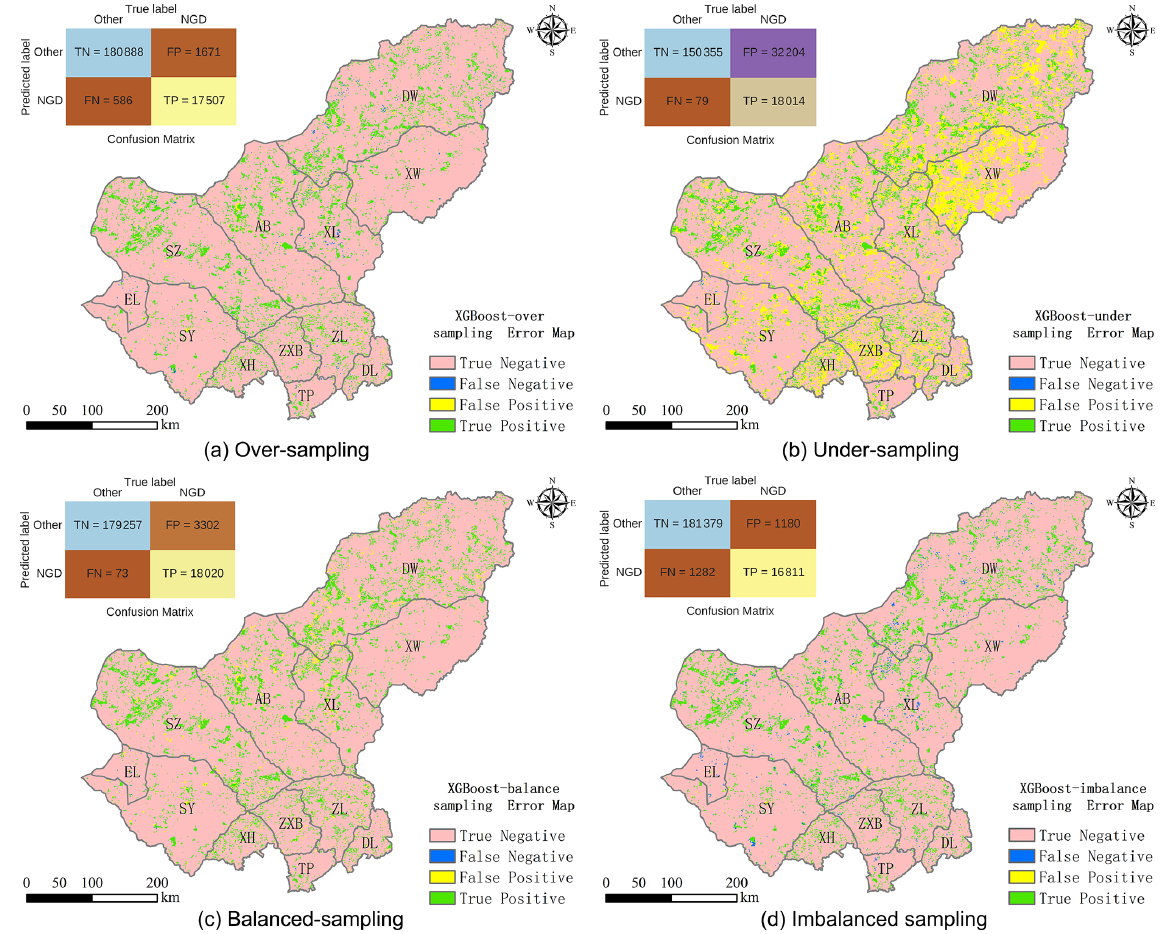
Figure 5. Error map of different sampling methods using the XGBoost